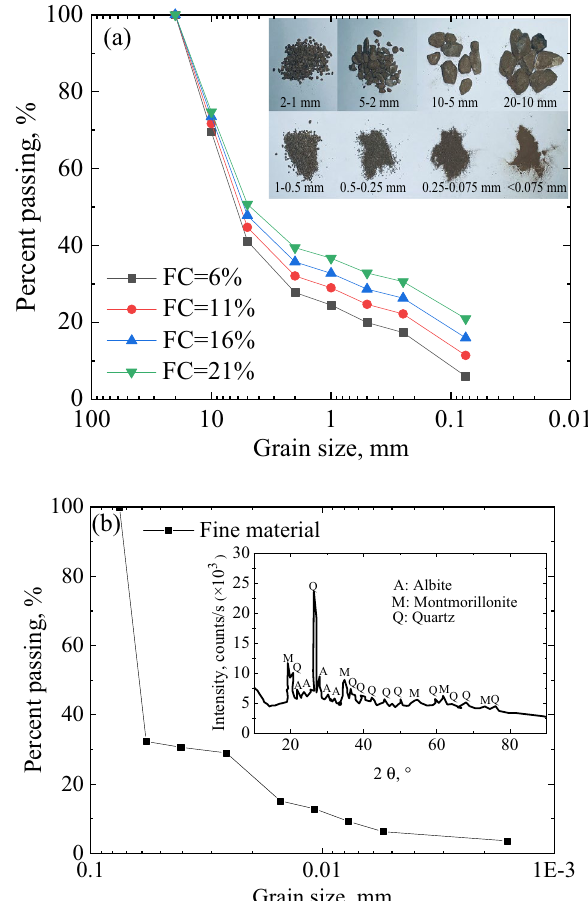
Figure 1. Grain size distribution of the samples: ( a ) focusing on the grain size more than 0.075 mm and ( b ) focusing on fines matrix and showing the XRD test